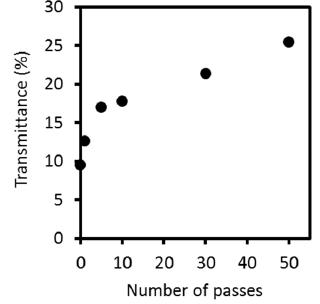
Figure 3. Regular light transmittances of protein/CaCO 3 /chitin nanofiber dispersions at 800 nm as a function of the number of passes.